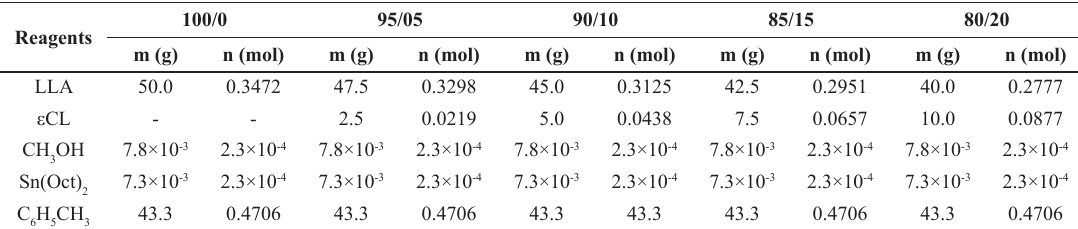
Table 1. Mass and molar composition of reaction media for the preparation of PLLA and its copolymers with PCL. Reagents